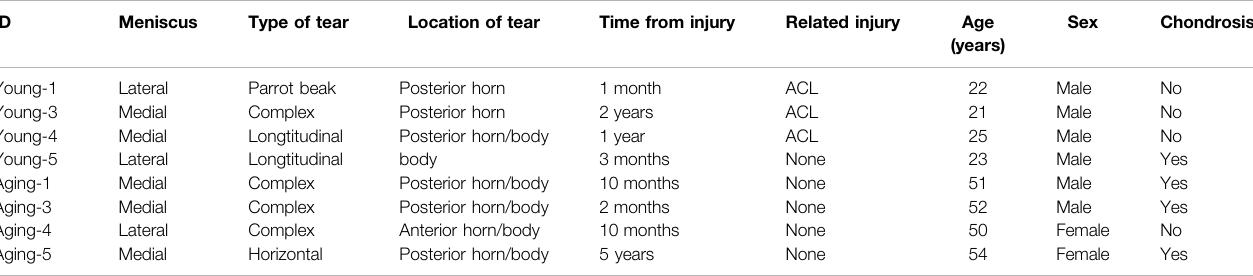
TABLE 1 | Basic clinical parameters of